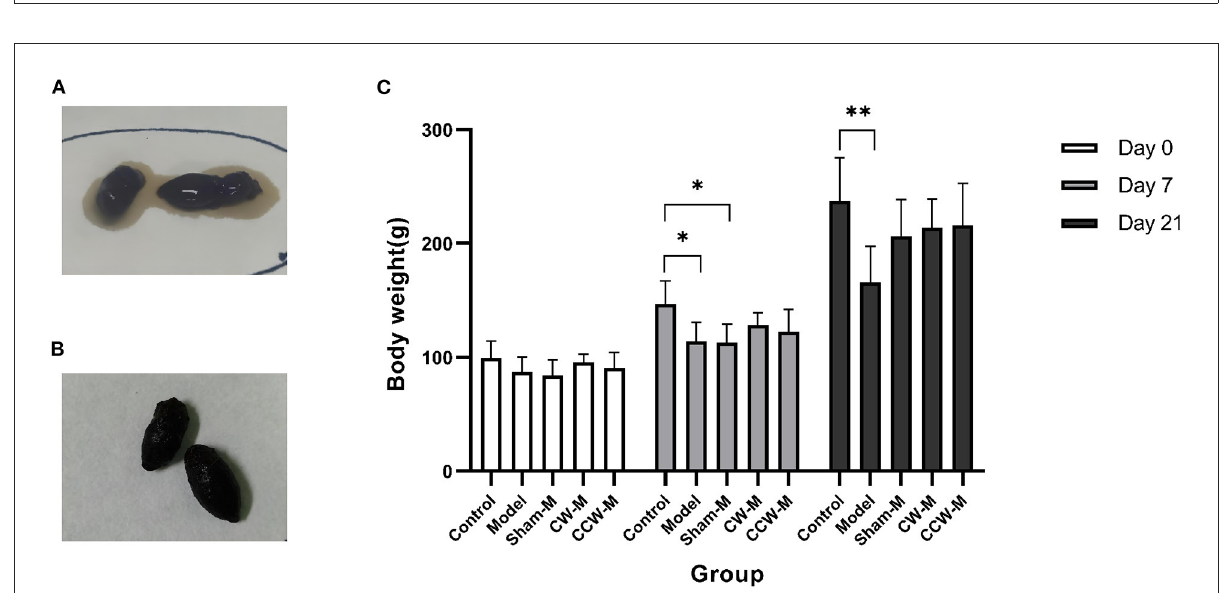
FIGURE2 (A) State of stool before abdominal massage. (B) State of stool after abdominal massage. (C) Body weight. Error bars are expressed as means ± SD ( n = 6). Statistical significance was determined by one-way ANOVA with Tukey tests for multiple-group comparisons. * P < 0.05; ** P <